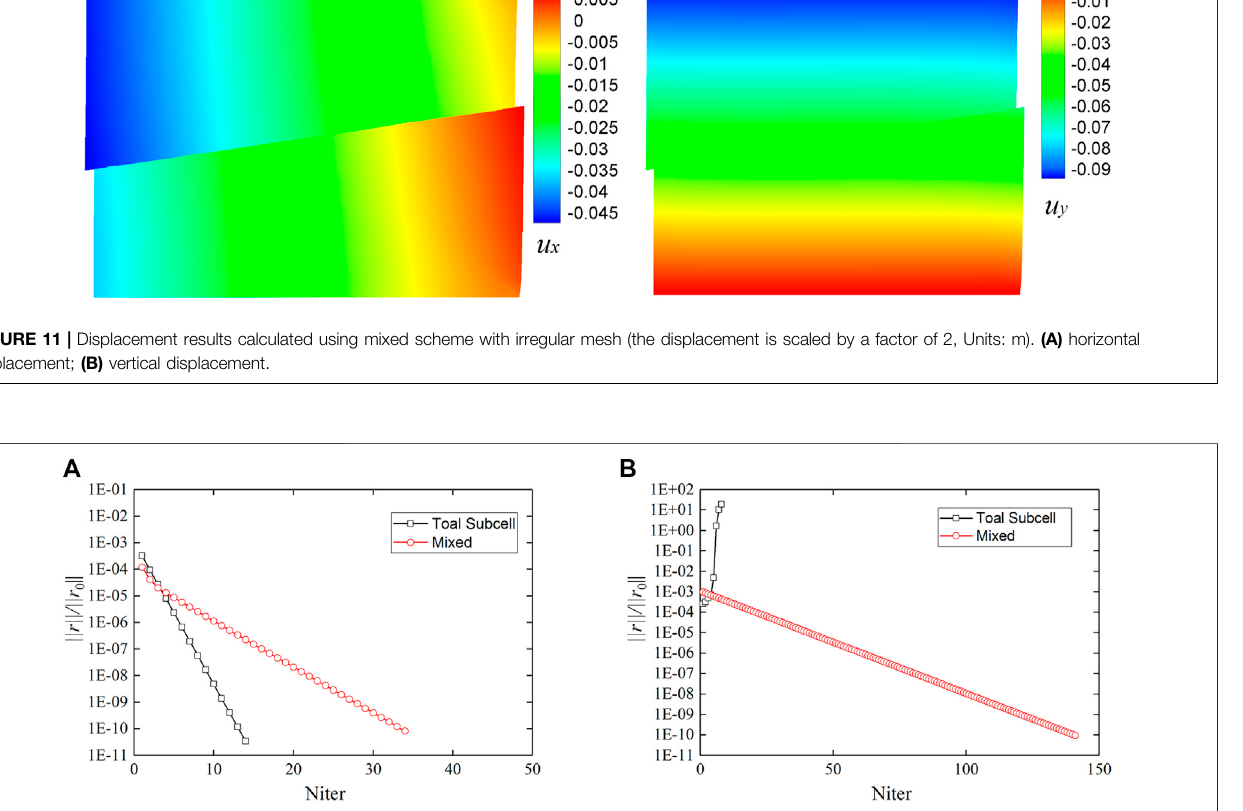
FIGURE 12 | Convergence pro fi les using mixed scheme and total subcell scheme. (A) Regular mesh; (B) Irregular mesh.